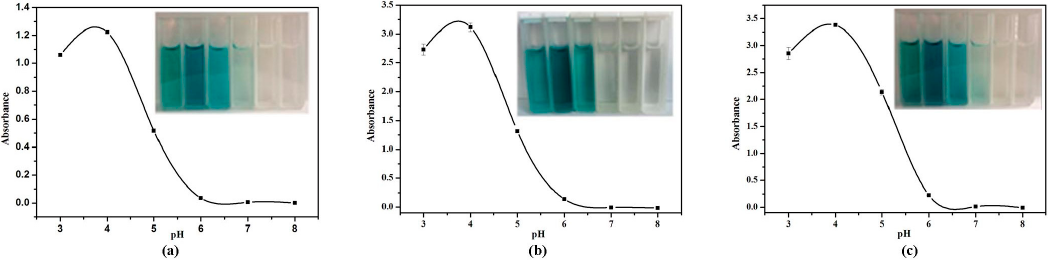
Figure 4. The effect of pH on absorption value with TMB and color changes. ( a ) VO 2 nanofibers; ( b ) VO 2 nanosheets; ( c ) VO 2 nanorods. The error bars represent the standard deviation of three measurements.